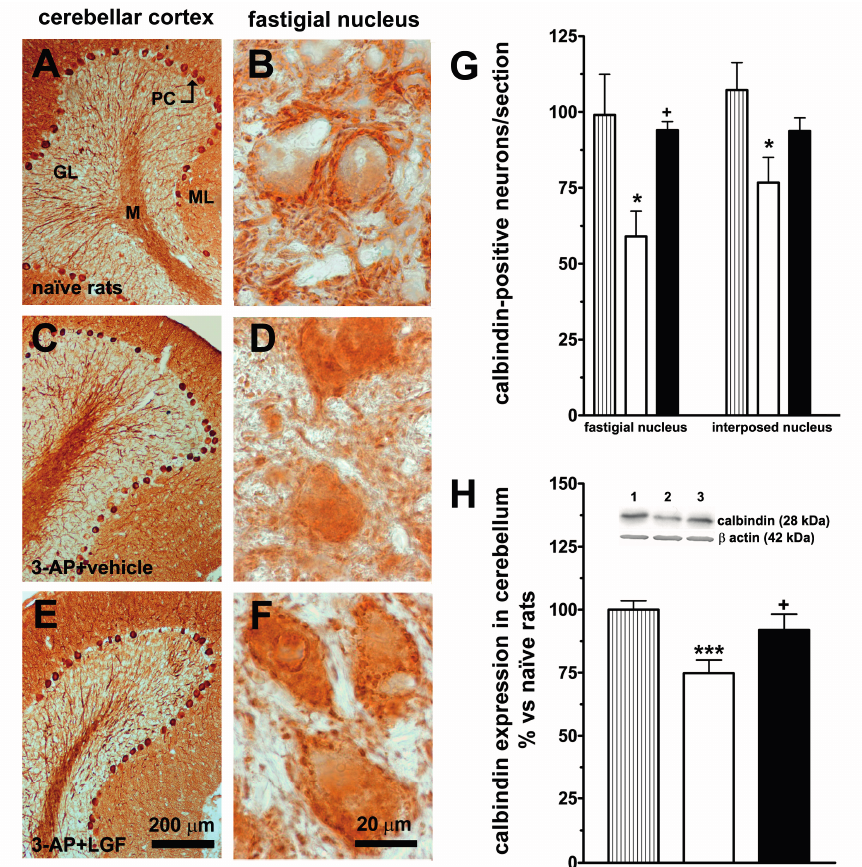
Figure 3. Liver growth factor modulates calbindin protein expression in the cerebellum of 3-acetylpyridine-lesioned rats. A to F show calbindin immunostaining in the cerebellar cortex ( A , C , E , brown) and the fastigial cerebellar deep nucleus ( B , D , F brown) of naïve ( A , B ), and 3-AP-lesioned rats treated with vehicle ( C , D ), or LGF ( E , F ); G shows the number of neurons that receive calbindin-positive projections in the fastigial and interposed cerebellar deep nuclei and H shows the detection by western blot of calbindin in the cerebellum. Note how 3-AP lesion reduces calbindin-positive projections ( G , white bars) and protein expression ( H , white bars) in comparison with naïve rats ( G , H , lined bars), and how LGF treatment preserves both parameters ( G , H , black bars). Lane 1: naïve rats (control); lane 2: 3-AP + vehicle; lane 3: 3-AP + LGF. Results represent the mean ± SEM of 4 ( G ) or 12 to 19 ( H ) individual animals. * p ≤ 0.05, *** p ≤ 0.001 vs. naïve rats, + p ≤ 0.05 vs. 3-AP + vehicle rats. Scale bars: 20 µm ( B , D , F ) and 200 µm ( A , C , D ). PC: Purkinje cells, GL: granular layer, ML: molecular layer, M: